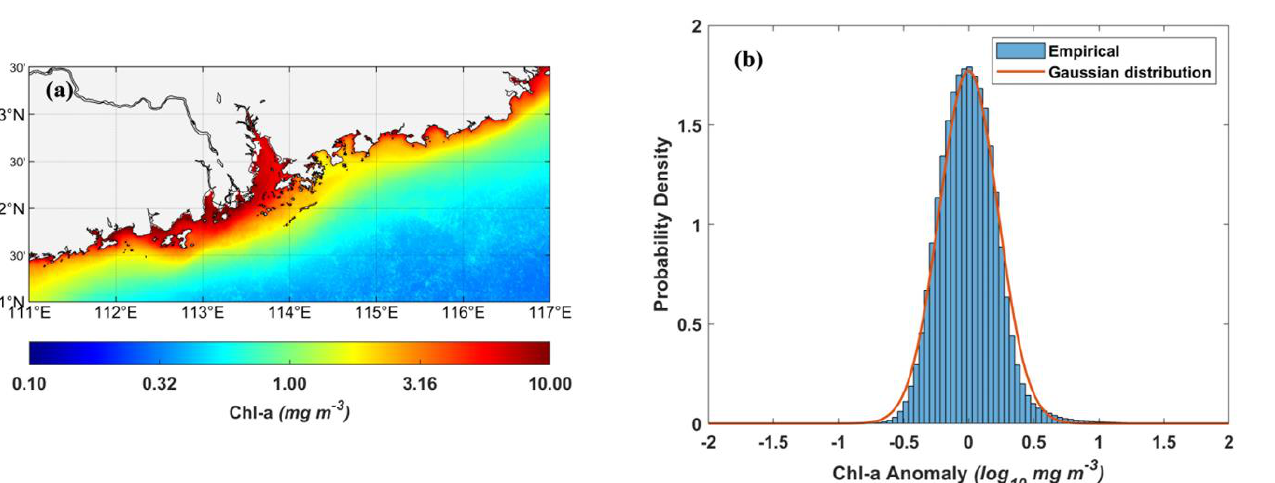
Figure 5. ( a ) Temporal variability of non-missing data coverage percentage and with low-pass filter of one month (red line); ( b ) mean percentage of non-missing data coverage.